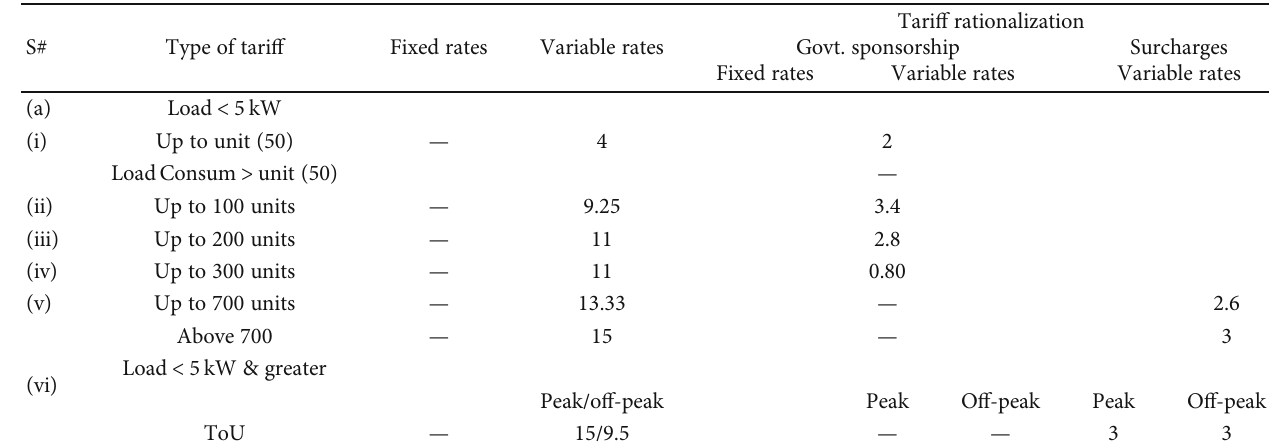
Figure 24: Daily electricity bill for fi ve proposed houses. Table 6: Utility tari ff set by